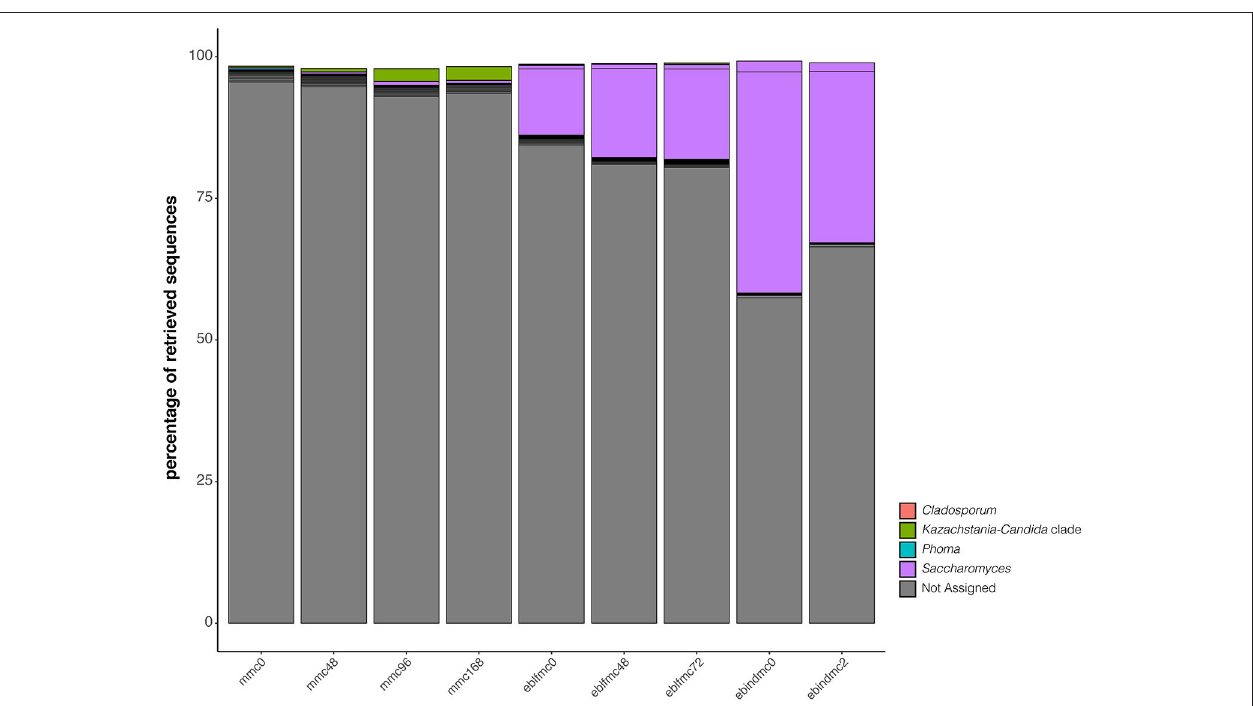
FIGURE 4 | Phylogenetic diversity of the first 20 most abundant ASVs for yeasts (18S rRNA gene) recovered from the massive sequencing analysis of the different types of bread doughs (MMC, sourdough; eblfmc, Elias–Boulanger long-fermentation raw dough; ebindmc, Elias–Boulanger industrial raw dough) at different times of fermentation.